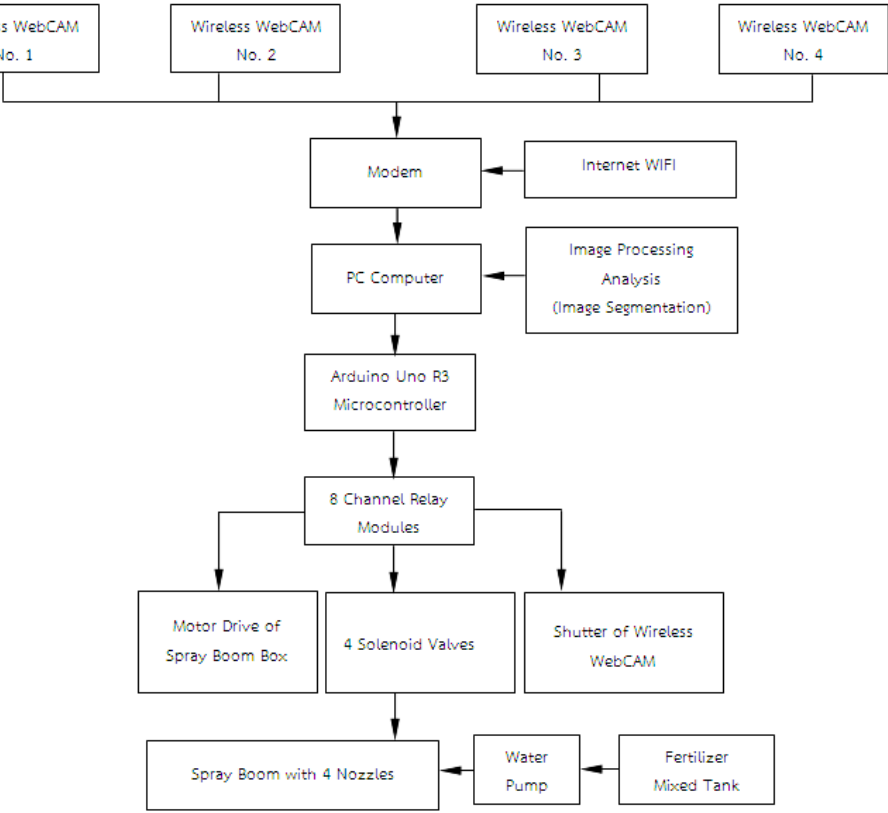
Figure 4. Variable rate spraying system with automatic direct fertilizer injection.